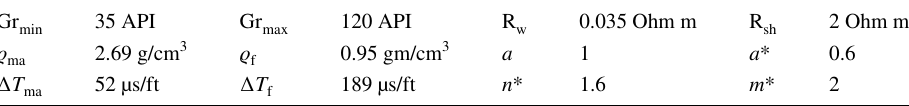
Fig. 4 Well logs interpretation workflow Table 3 Constants